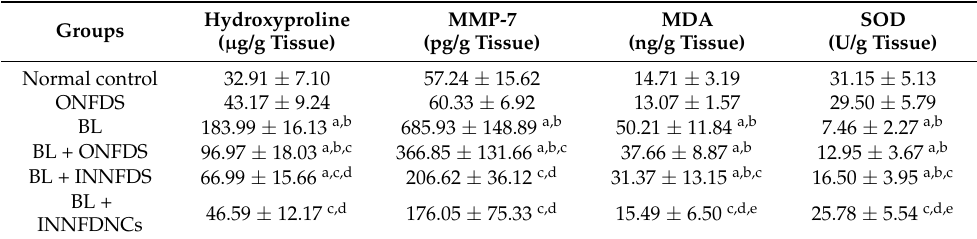
Table 7. Biochemical analyses in different studied groups.